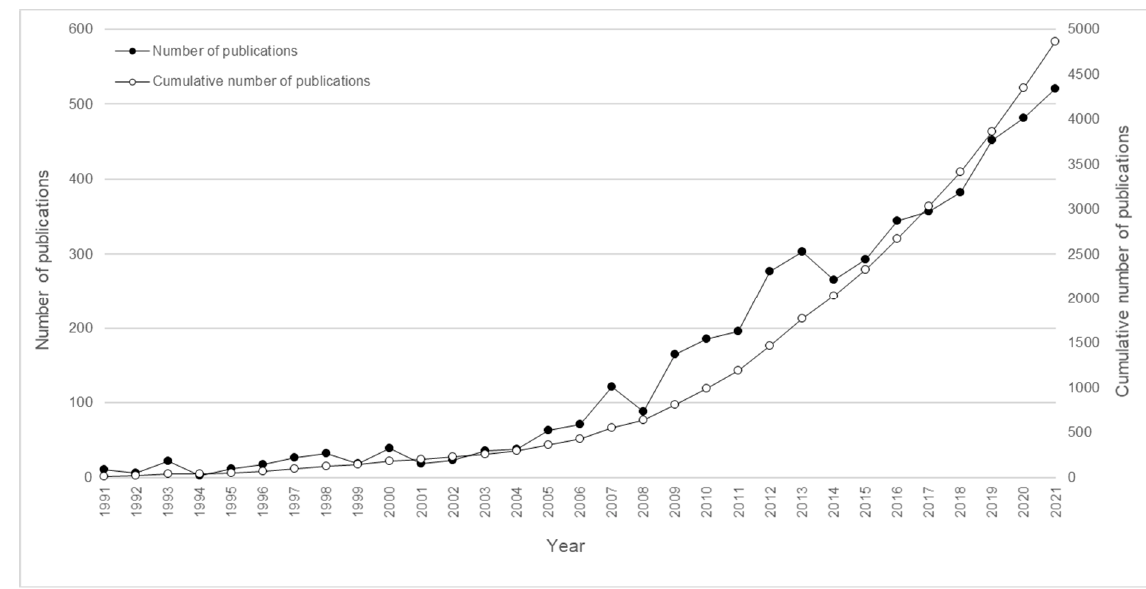
Figure 10. Number of safety culture publications and cumulative number of safety culture publica- tions by year (1990–2021) (Adapted from [2]).